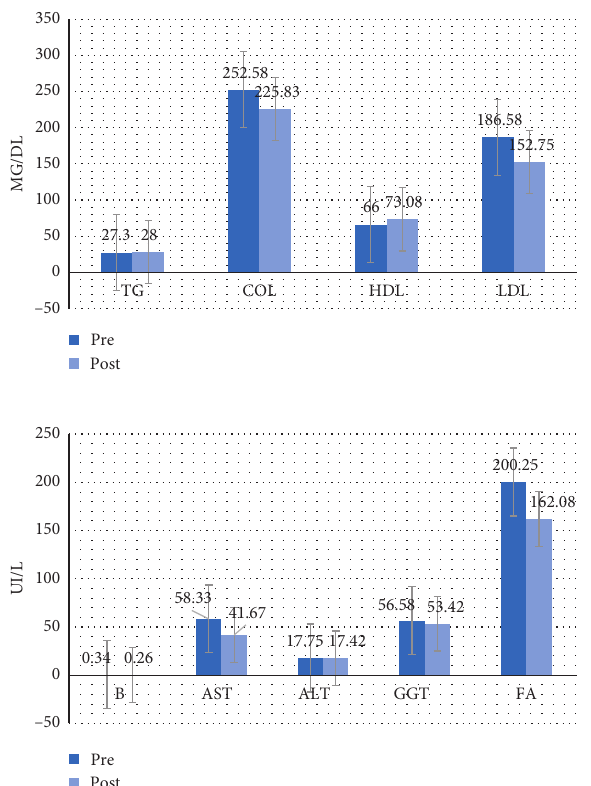
Figure 4: Average values of the pre-post parameters for group 1. TG � triglycerides, COL � total cholesterol, HDL � HDL choles- terol, LDL � LDL cholesterol, B � bilirubin, AST � aspartate ami- notransferase, ALT � alanine aminotransferase, GGT � gamma- glutamyl transferase, FA � alkaline phosphatase.